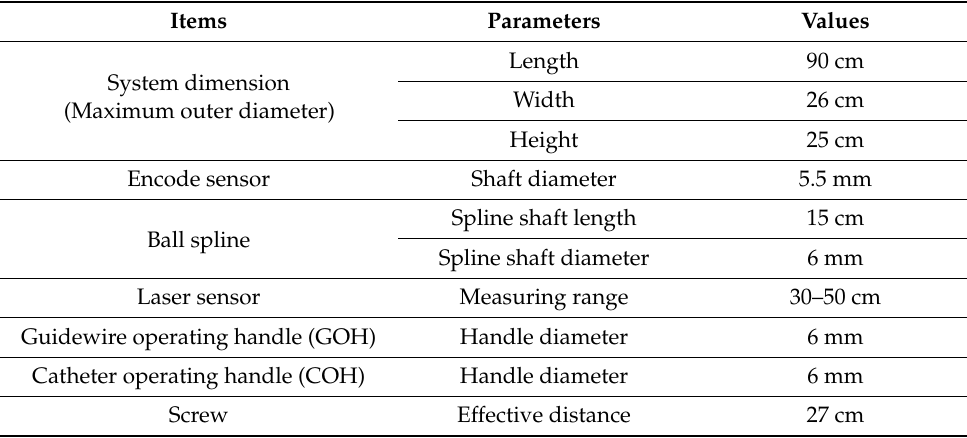
Table 1. The related technical parameters of the designed master haptic